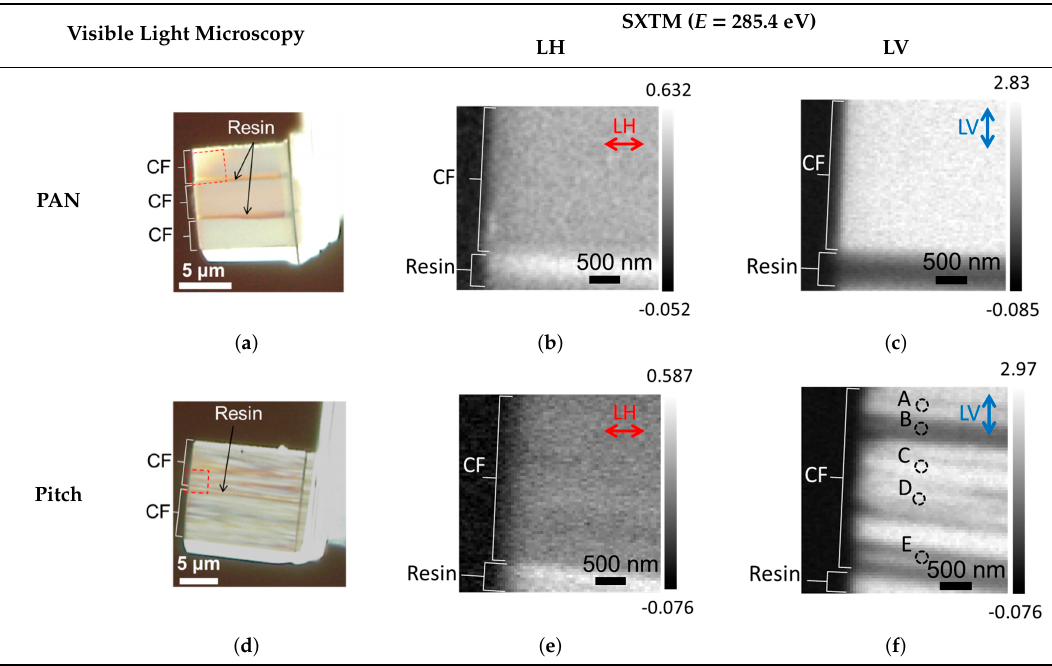
Figure 1. Average C K -edge spectra of the CF areas in Table 3b,c.